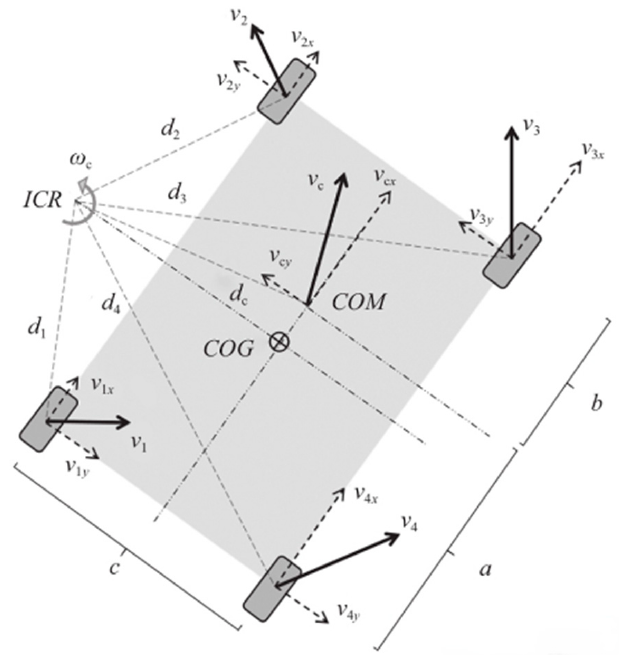
Figure 5. Four-wheel differential model. ICR is the rotate center; COG is the geometric center; d i is the distance from the four wheels to the ICR; COM defines the centroid ; d c is the distance from COM to the ICR; c is the wheelbase of the left wheel to the right wheel; a is the distance from COM to the backend; and b is the distance from COM to the front end.